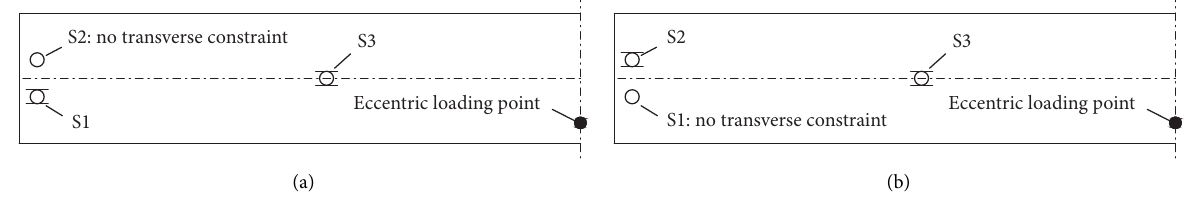
Figure 13: Different positions of the transverse constraint of the end bearings in the models. (a) The original model. (b) The reference Table 3: Reactions at critical states calculated from the models with different transverse constraints (unit: kN). Model